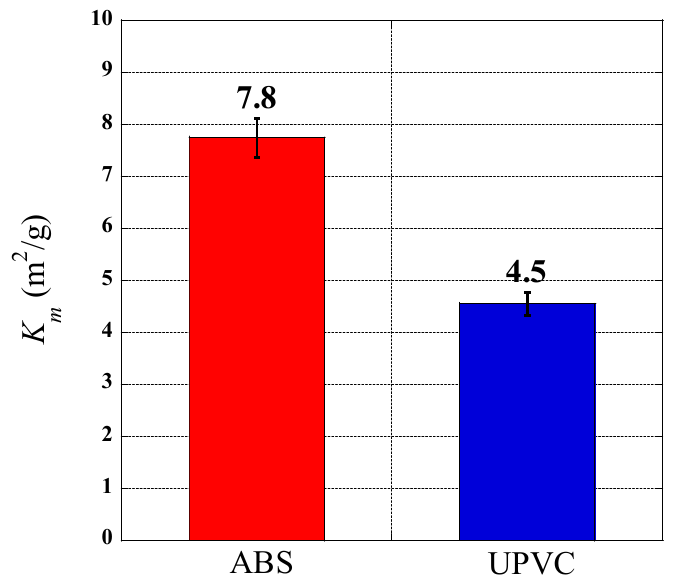
Figure 6. Comparisons of calculated mass-specific light-extinction constant for ABS and UPVC smoke particles.